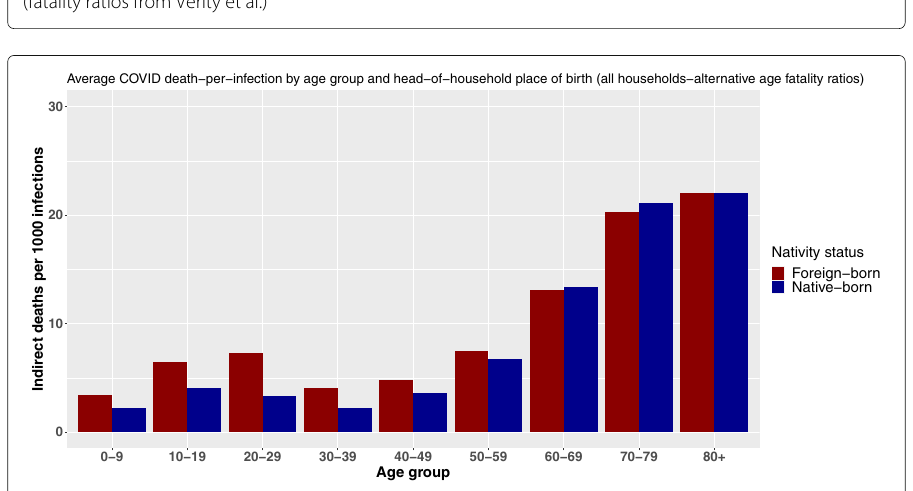
Fig. 16 Average COVID-19 deaths per 1000 infections by age group and head-of-household nativity status (fatality ratios from Verity et al.)